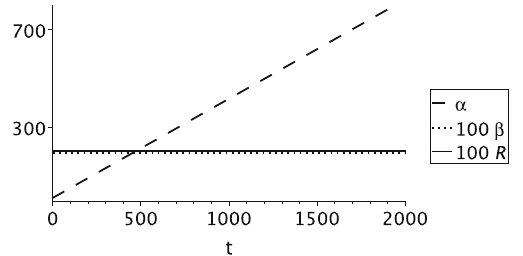
Fig. 3 Numerical solution to the system of equations (8), (9) and (10) for initial conditions α( 0 ) = 15 , β( 0 ) = b c (cid:4) 1 . 9930281 , ˙ α( 0 ) = H (cid:4) 0 . 4046668 ( b c , H are found from Eqs. (19), (20)) ˙ β( 0 ) = 0 , ˙ R ( 0 ) = 0. R ( 0 ) (cid:4) 2 . 0764993 is found from Eq. (11). For the found numerical solution k = − 2 . 98 , a = − 2 . 77 , c = − 0 . 49